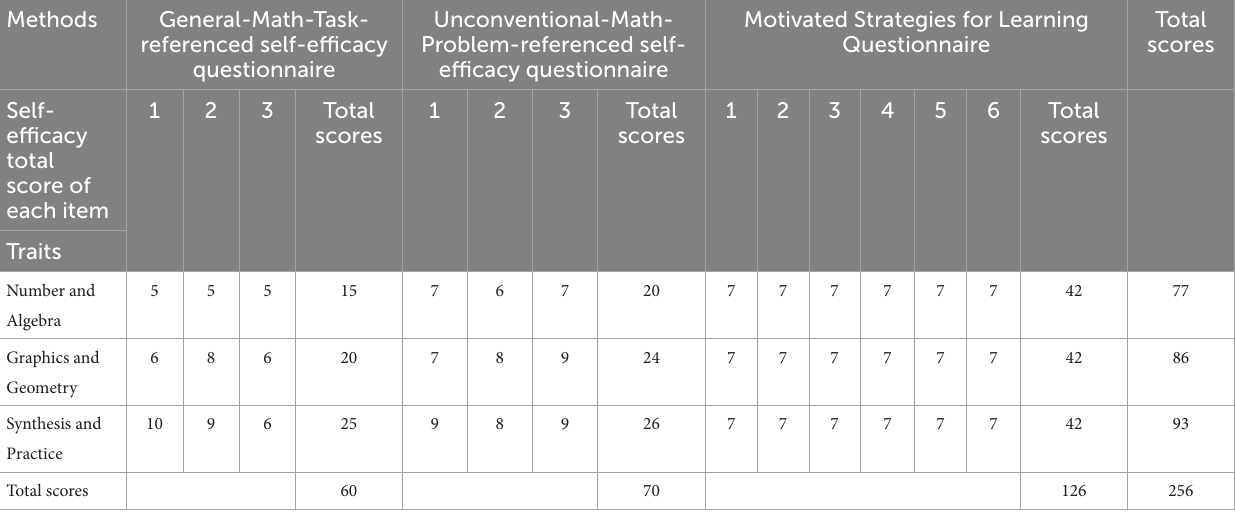
TABLE 2 Scores of each index of the